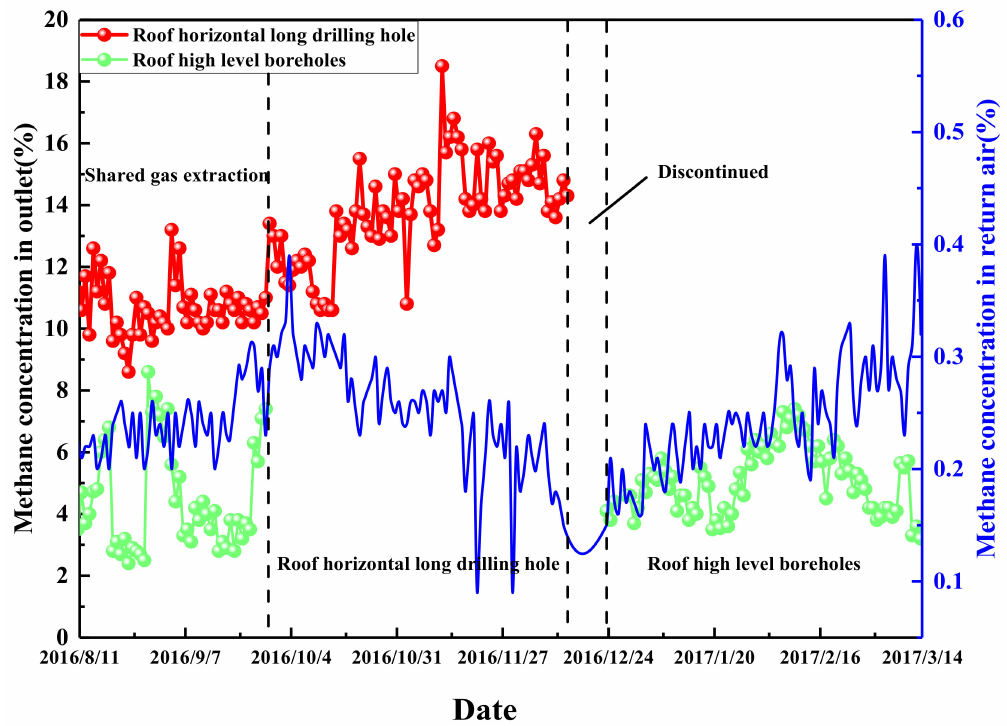
Figure 13. Relationships of methane concentrations in both discharge outlet and return airflow to time. Short-term shutdown occurs due to equipment maintenance problems. Red broken line: variation in methane concentration in the return air flow after the roof long horizontal borehole used. Green fold line: variation in methane concentration in the return air flow after the roof high level borehole used. Blue broken line: change in methane concentration at the discharge